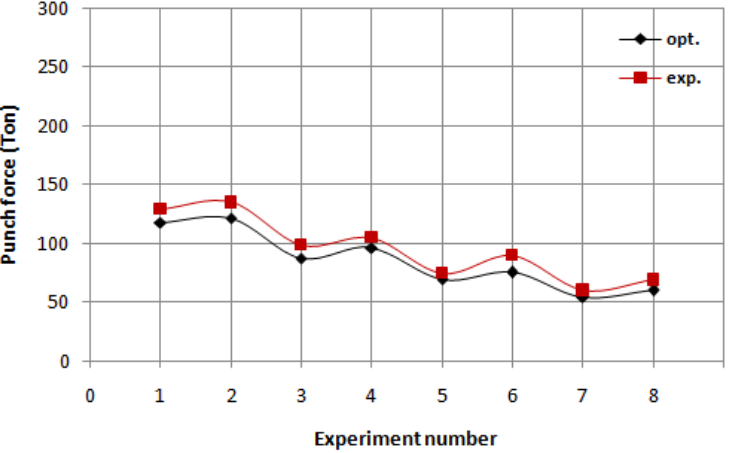
Figure 18. Comparison of DE optimal and experimental values for punch force.